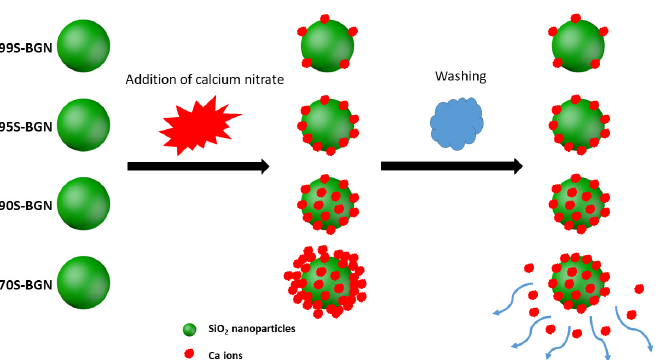
Figure 3. Schematic illustration of the mechanism of Ca incorporation into BGNs in the Stöber